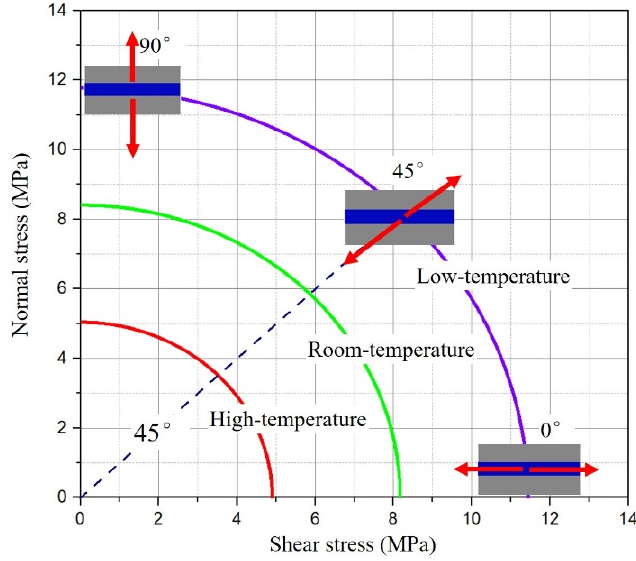
Figure 16. Stress criterion envelope of adhesive joints under whole service temperature.